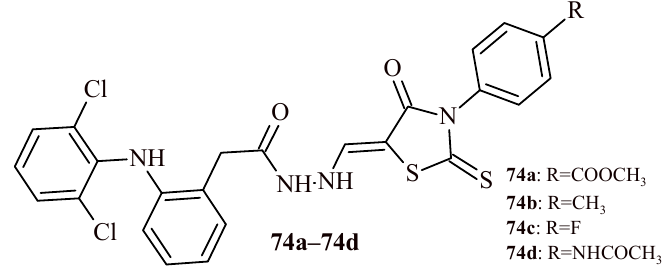
Figure 30. The rhodanine-diclofenac hybrids with anti-inflammatory